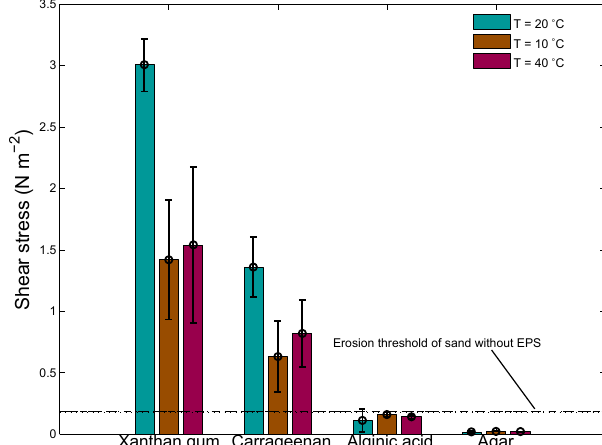
Figure 8. The threshold for erosion as a function of pH for four extracted EPSs as measured with the CSM erosion device. The hor- izontal lines correspond to the threshold for erosion of sand without EPSs for water with a pH of 7 (dashed), a pH of 4 (dotted) and a pH of 10 (dash dotted). Error bars are standard deviations from n = 3 repeat measurements.